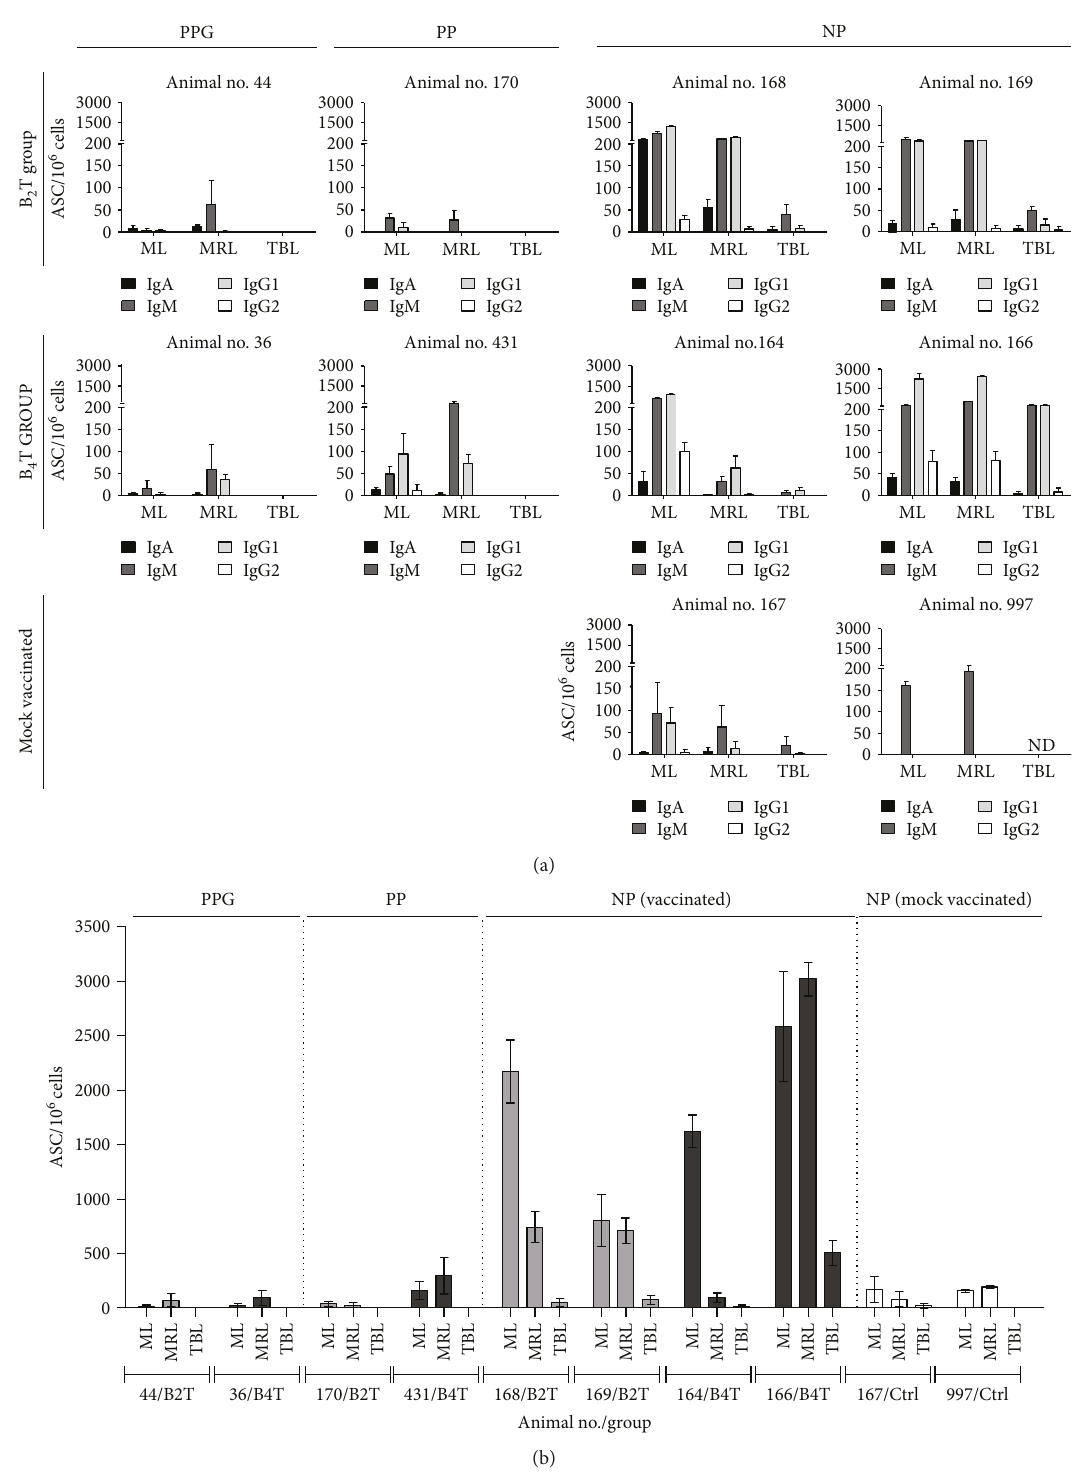
Figure 3: Pro fi les of the FMDV-ASC detected in B T- and B T-vaccinated cattle after FMDV challenge. (a) Mononuclear cells were puri fi ed 2 4 from mandibular lymph nodes (ML), medial retropharyngeal lymph nodes (MRL), and tracheobronchial lymph nodes (TBL) and characterized by the FMDV-ASC ELISPOT assay, using monoclonal (IgG1 and IgG2) or polyclonal (IgM and IgA) antibodies against bovine immunoglobulin isotypes as probes. (b) Total FMDV-ASC in ML, MRL, or TBL. Results are expressed as the mean number of FMDV-speci fi c ASC per 1 × 10 6 extracted cells. Each bar represents the mean value of 3 replicates ± SD. PPG: protected against podal generalization; PP: partial protected; NP: